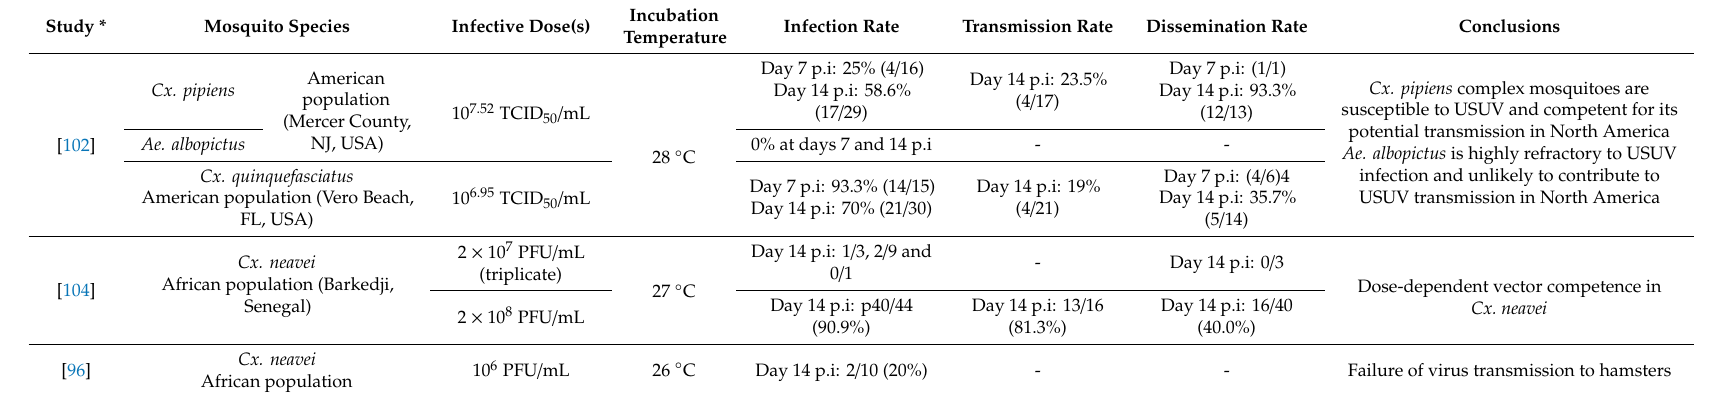
Table 4. Infection studies with USUV in non-European mosquito